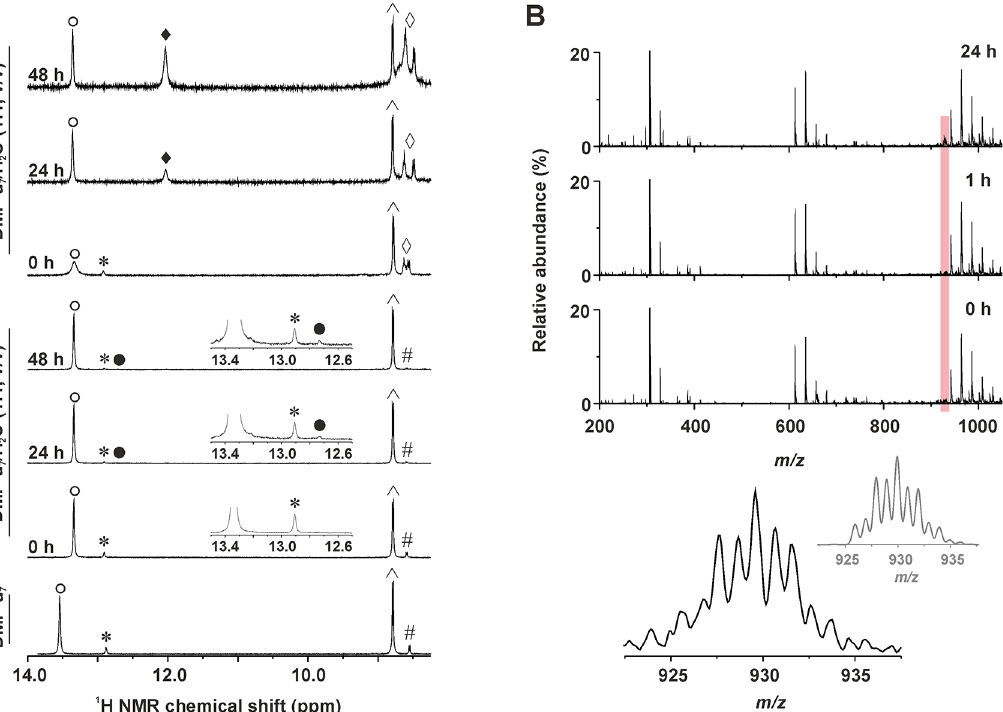
Fig 4. Time-dependent studies of stability of 3 ( 1 H NMR) and its interaction with GSH ( 1 H NMR and ESI-MS). (A) 1 H NMR spectra of cis - [PtCl 2 ( 4Br aza) 2 ] ( 3 ) dissolved in DMF- d 7 or DMF- d 7 /H 2 O mixture (1:1, v/ v) without or with glutathione (GSH) measured at different time points (0, 24 and 48 h). (cid:2) = N1 – H, cis -[PtCl 2 ( 4Br aza) 2 ]; * = N1 – H, trans -[PtCl 2 ( 4Br aza) 2 ]; ● = N1 – H, hydrolysis product, cis -[Pt( 4Br aza) 2 (H 2 O)Cl] + ; ♦ = N1 – H, GSH adduct of 3 ; ^ = C6 – H, cis -[PtCl 2 ( 4Br aza) 2 ]; # = C6 – H, trans -[PtCl 2 ( 4Br aza) 2 ]; ^ = N – H of glycine and cysteine of GSH. (B) ESI – mass spectra (200 – 1050 m/z range) of the mixture of 3 with GSH (dissolved in the methanol/H 2 O, 1:1, v/v ) as detected at different time points (0, 1 and 24 h). The region of the {[Pt( 4Br aza) 2 Cl (GSH)] – 2H} − species is highlighted by red colour. The detail of the experimental peak of {[Pt( 4Br aza) 2 Cl(GSH)] – 2H} – , as observed after 24 h, is given below (bottom left, given in black) together with the simulated isotope distribution (bottom right, given in